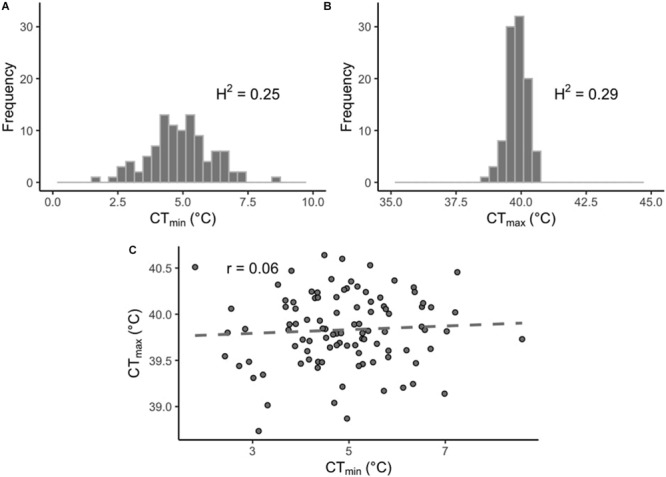
Distribution of thermal limits in the DGRP. Histograms of mean phenotypes across 100 DGRP lines for (A) CTmin and (B) CTmax. (C) Correlation between line-means of CTmin and CTmax.